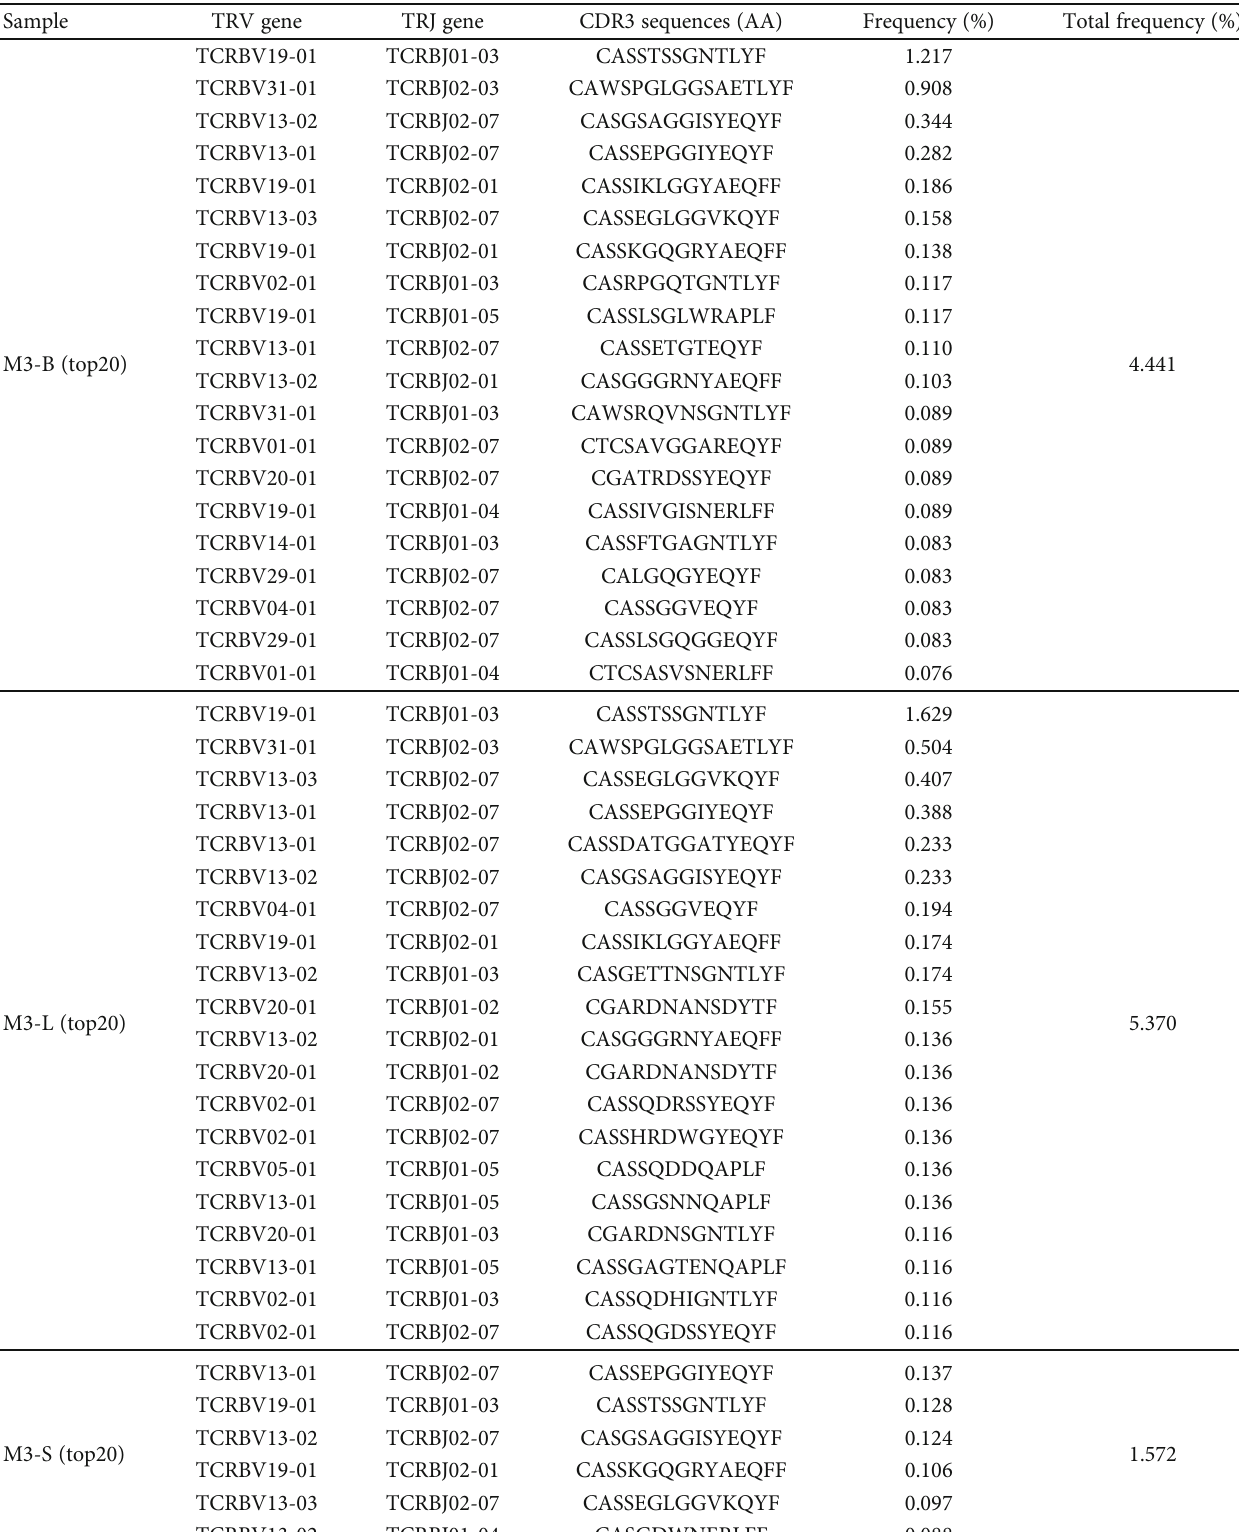
Table 10: Analysis of composition and characteristics of frequency for the top twenty sequences and the usage of TRBV and TRBJ gene, CDR3 AA of CD4 + CD25 + T cells TCR β CDR3 repertoires in breast tumor tissues, lung metastatic tissues, and spleens from 4T1 tumor-bearing BALB/c mouse